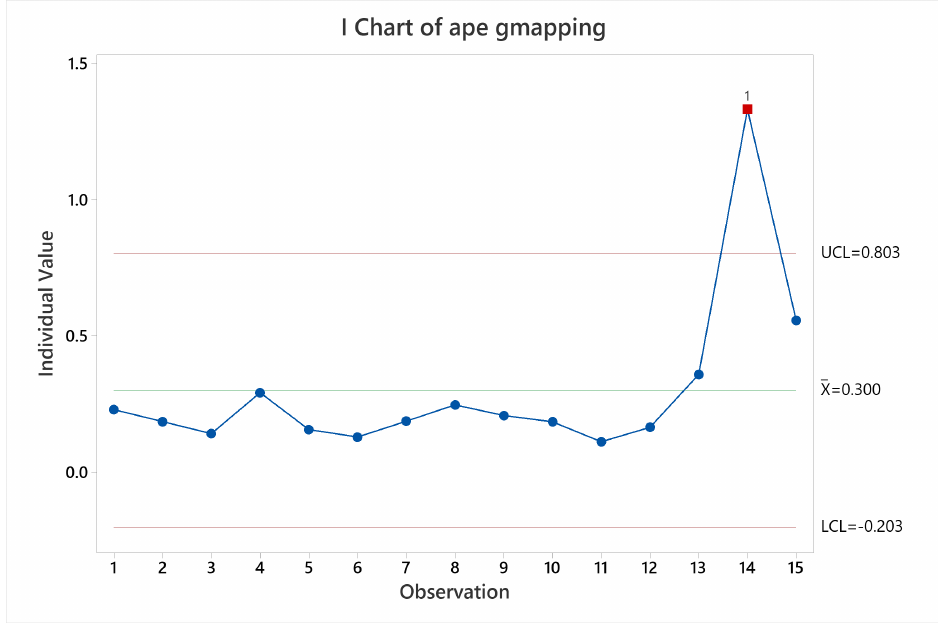
Figure 16. Pose accuracy mean behavior for Gmapping.